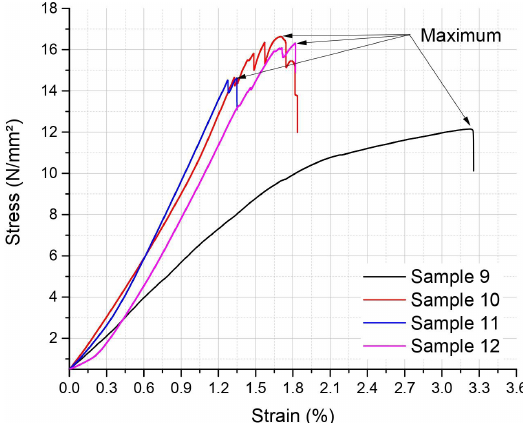
Figure 10. Flexure results of FRP-G hybrid beams (Samples 9 to 12).